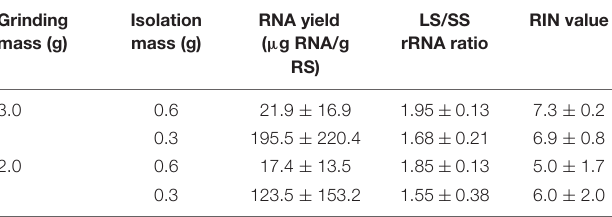
TABLE 2 | Comparison of RNA yield and quality from rumen solid (RS) with different amount of TRIzol solution.